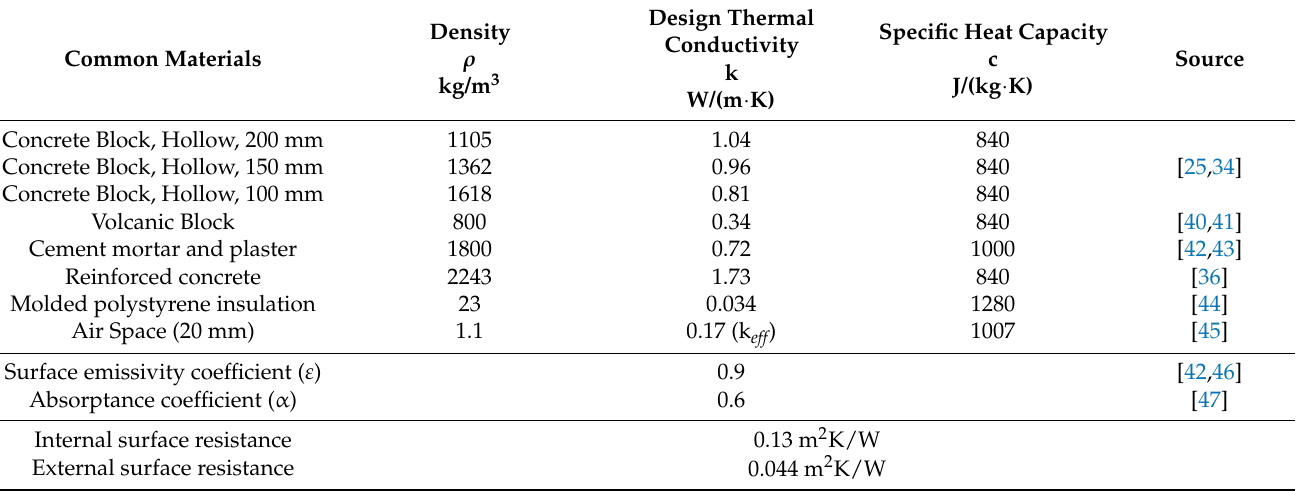
Table 1. Material properties used in finite element modelling.